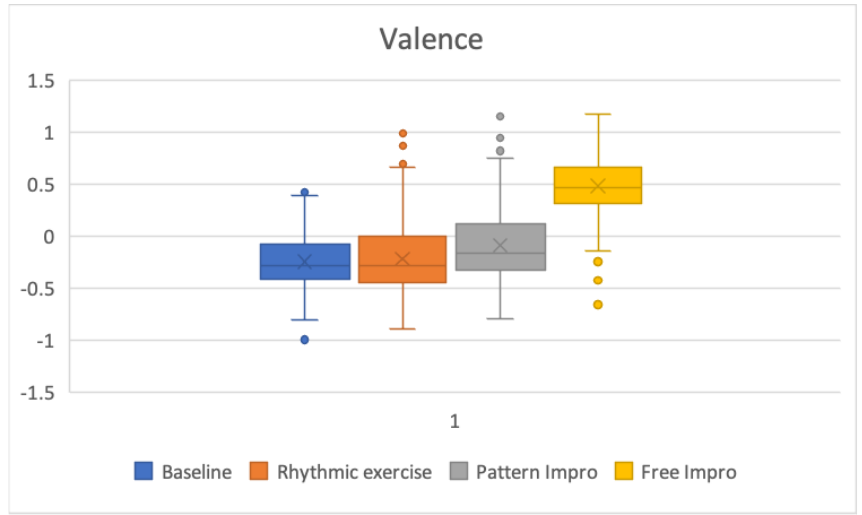
Figure 5. Box plot of the valence values for the baseline, rhythmic exercise, pattern improvisation, and free improvisation tasks.